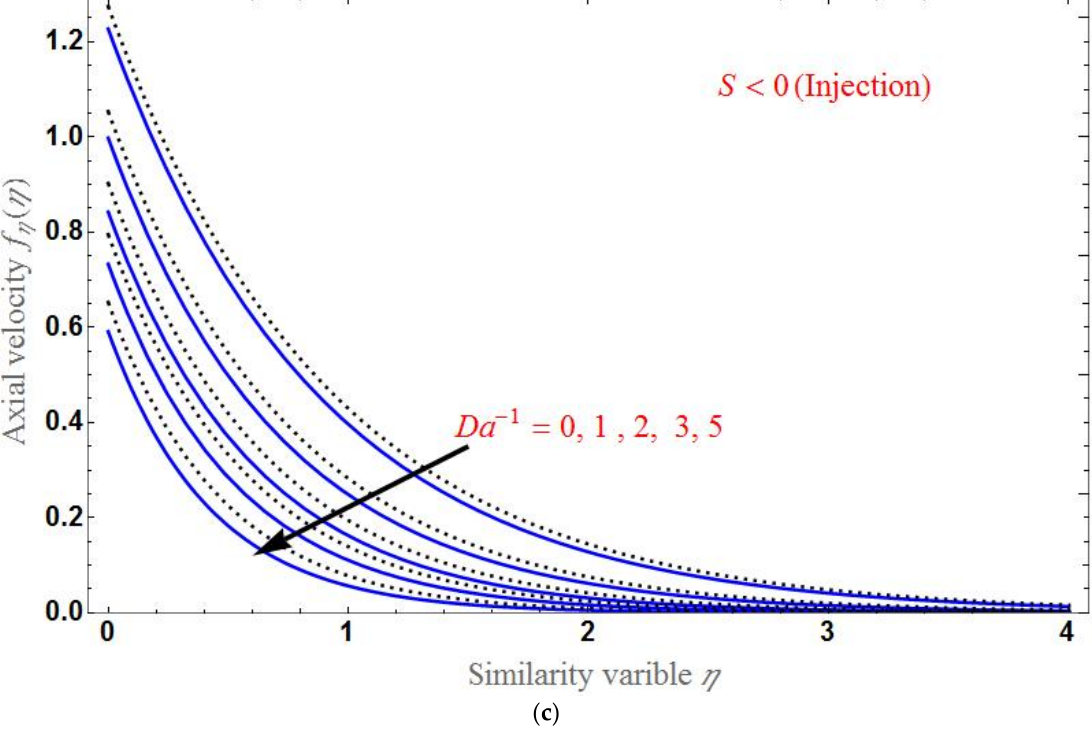
1 − Da Figure 2. The axial velocity as a function of  for various values of and for three different 1 Da − Figure 2. The axial velocity as a function of η for various values of and for three different Figure 2. The axial velocity as a function of η for various values of Da − 1 and for regimes of S : ( a ) S = 0, ( b ) S = 1, and ( c ) S = −1 . The other fixed parameters are: regimes of S : ( a ) S = 0, ( b ) S = 1, and ( c ) S = − 1. The other fixed parameters are: three different regimes of S : ( a ) S = 0, ( b ) S = 1, and ( c ) S = − 1. The other fixed parameters are: 1, 0.1, 0.04. M   = = = Λ = M = 1, φ = 0.1, φ = 0.04. 1 2 1, 0.1, 0.04. M φ φΛ = = = = 2 1 1 2 ( ) η η Λ f Figure 3 depicts the velocity as a function of for various values of . η Λ . Panels (a)–(c), where the velocity is exam- The velocity increases with an increase in ined for 0 S = , show that there is no permeability. For suction 1 S = and injection 1 S = − , we observe that the difference between the axial velocity of the base fluid and HNF is larger in the case of suction and smaller in the case of injection. In all cases, the axial velocity is less for an HNF than the base fluid.